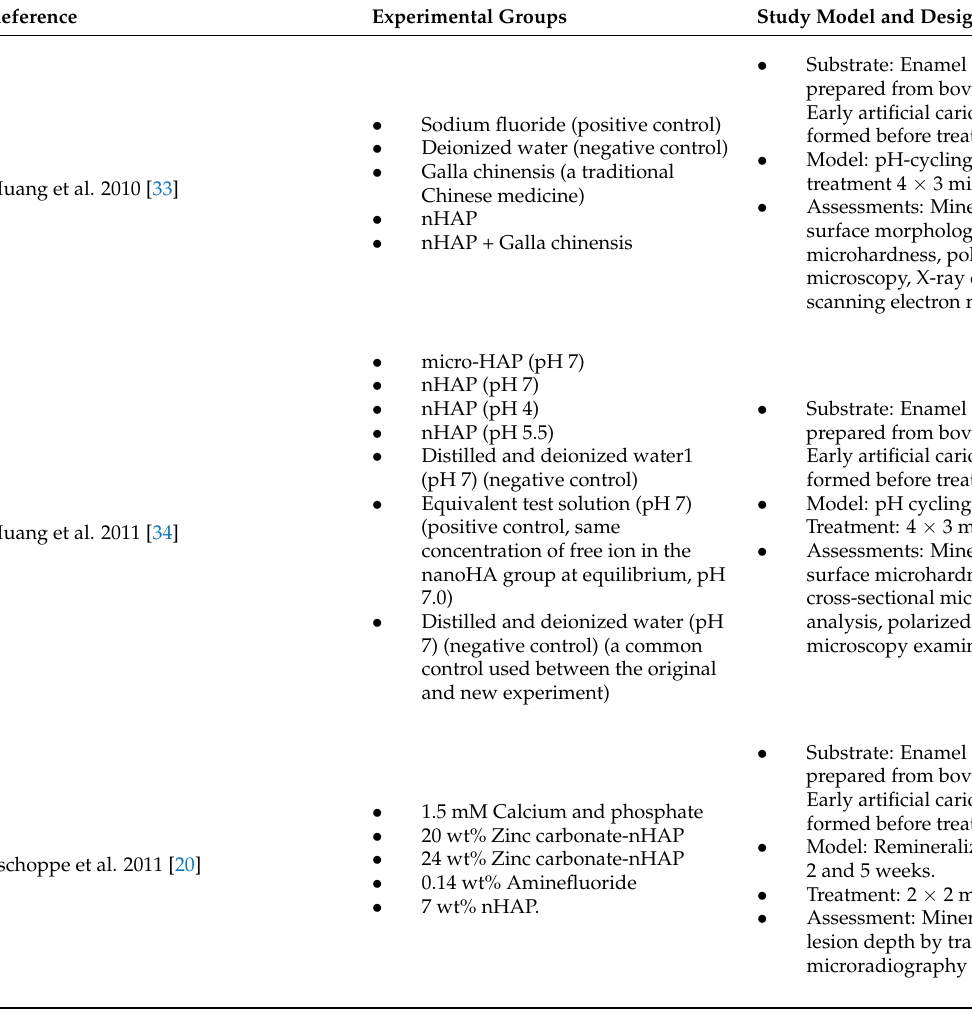
Table 1. Summary of the effect of hydroxyapatite nanoparticles on enamel